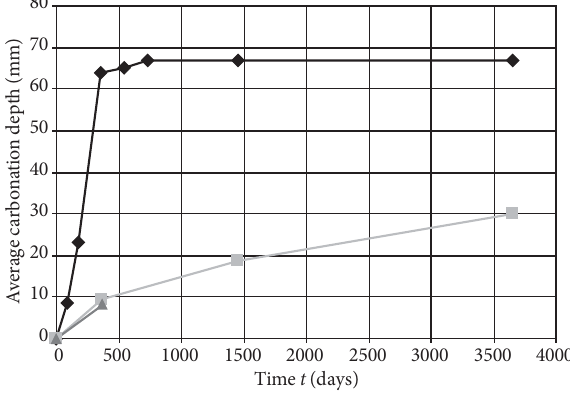
Average carbonation depth of common concrete prisms placed in an atmosphere of 98% Co 2 Carbonation depth of common concrete determined by calculation using Fick's law in an atmosphere of 0.03% CO 2 Average carbonation depth of common concrete prisms placed in an atmosphere of 0.03% CO 2 Fig. 3. Diff erent carbonation depths in an atmosphere of 98% and in the natural atm CO 2